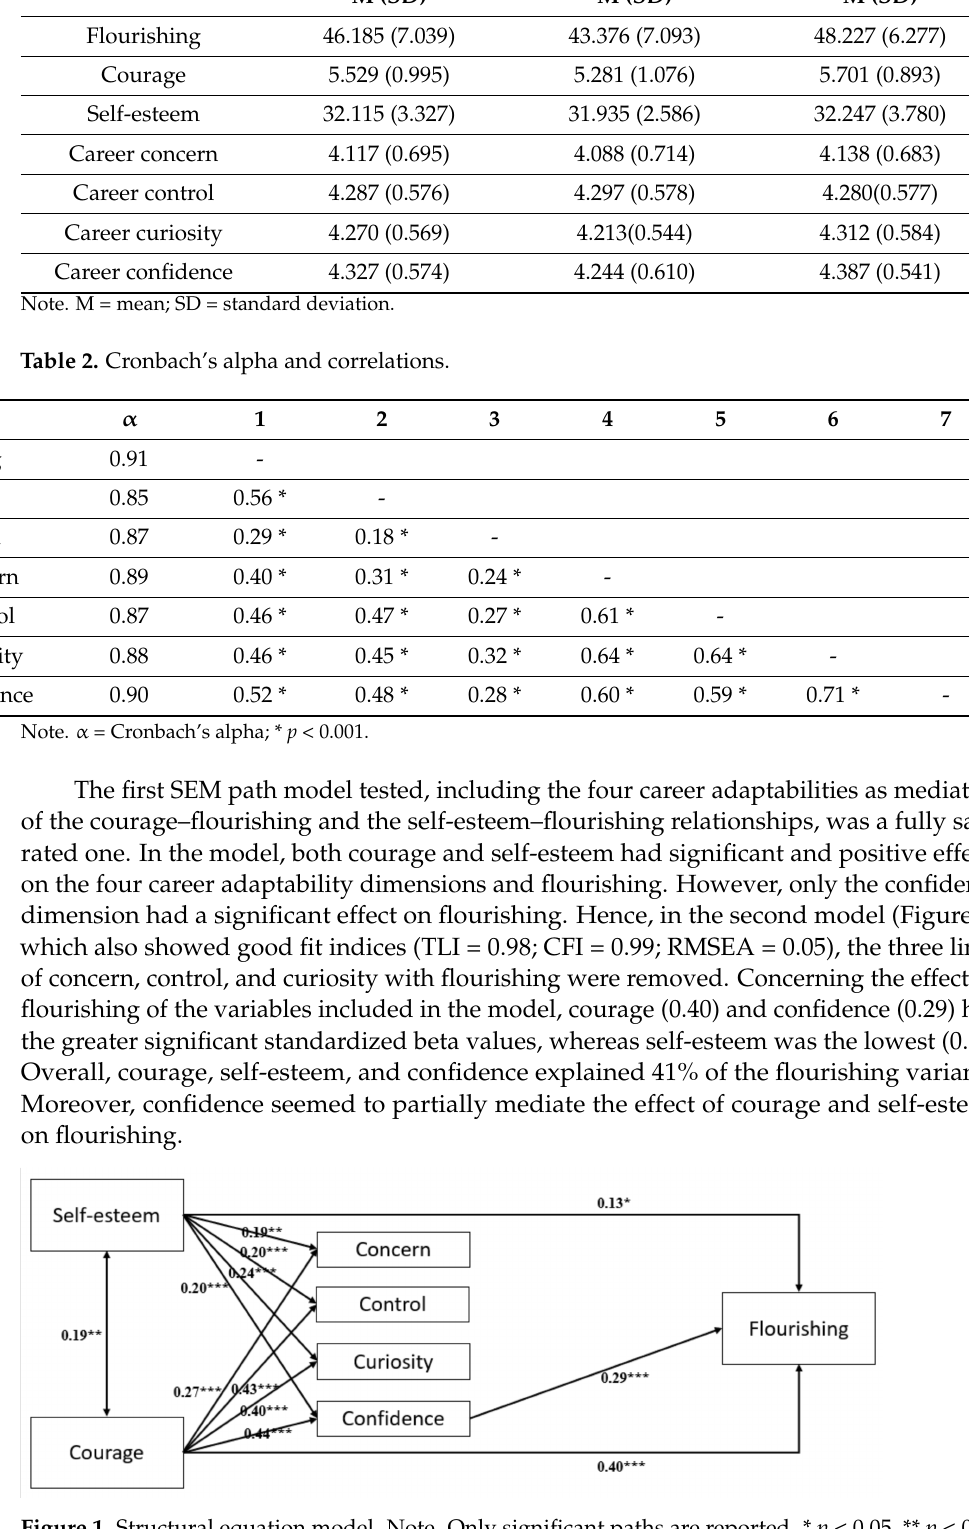
Figure 1. Structural equation model. Note. Only significant paths are reported. * p < 0.05, ** p < 0.01, *** p <